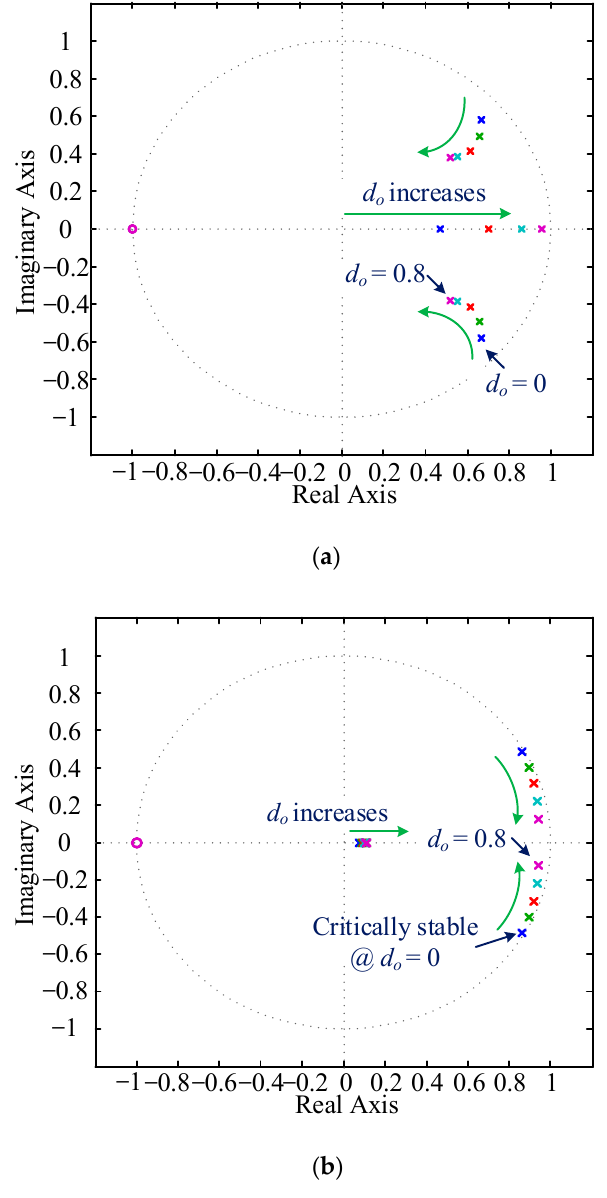
Figure 6. Pole-zero map of the closed-loop voltage control: ( a ) With damping controller ( G d ( z ) = 4), ( b ) Without damping controller ( G d ( z ) = 1).